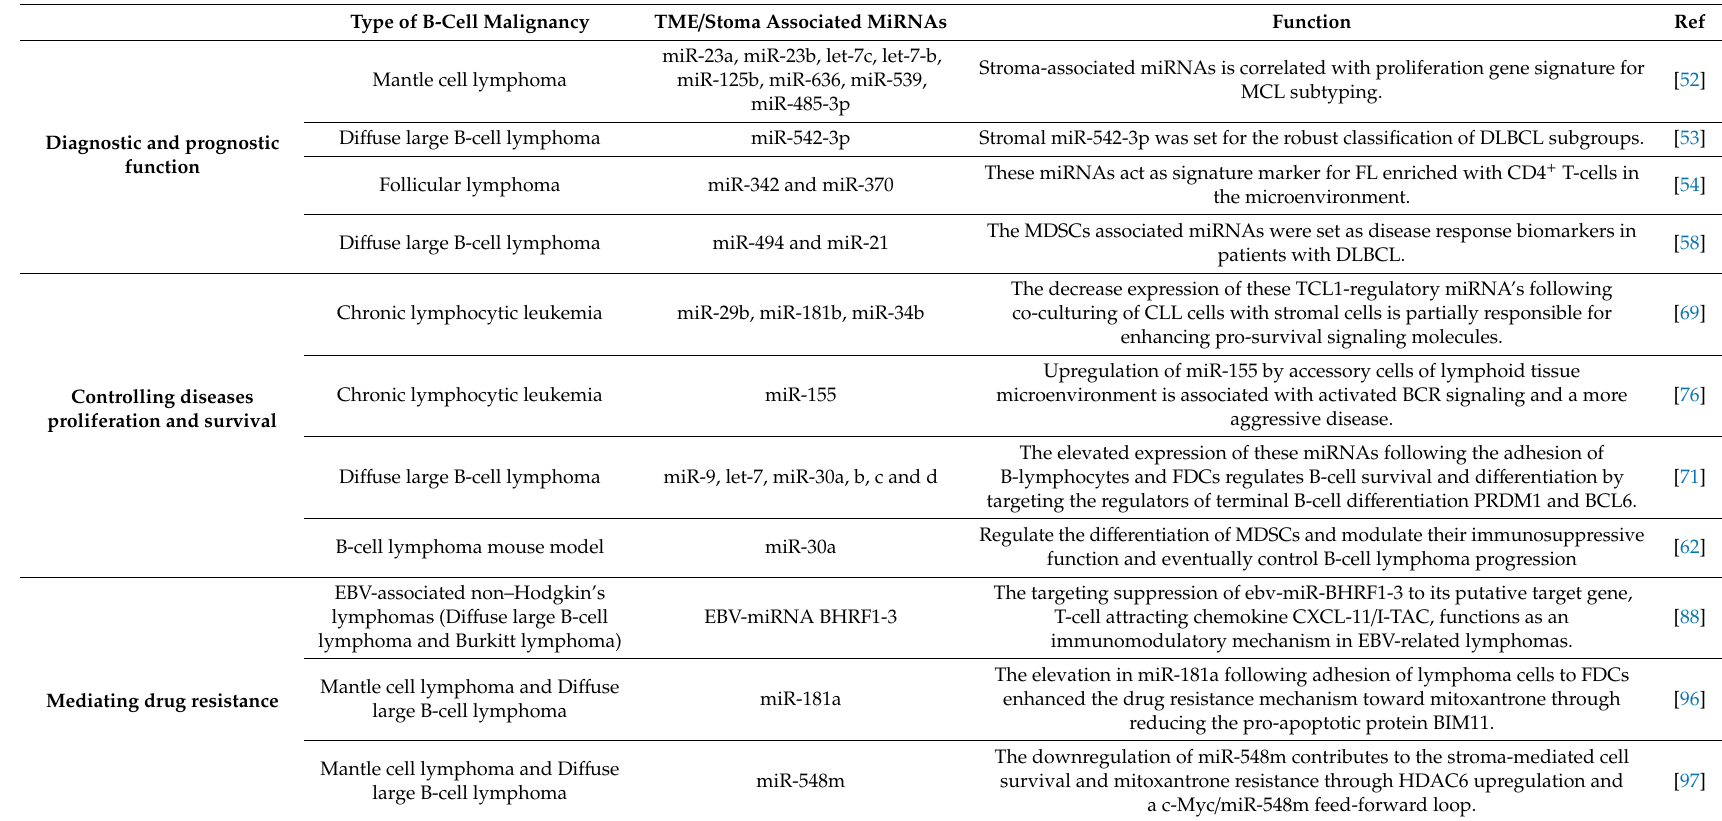
Table 1. List of miRNAs that are involved in the interplay between TME / stroma and tumor cells in the di ff erent B-cell